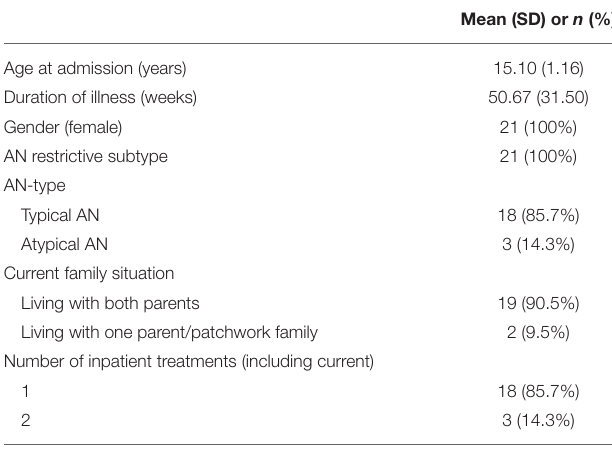
TABLE 1 | Demographic data of the 21